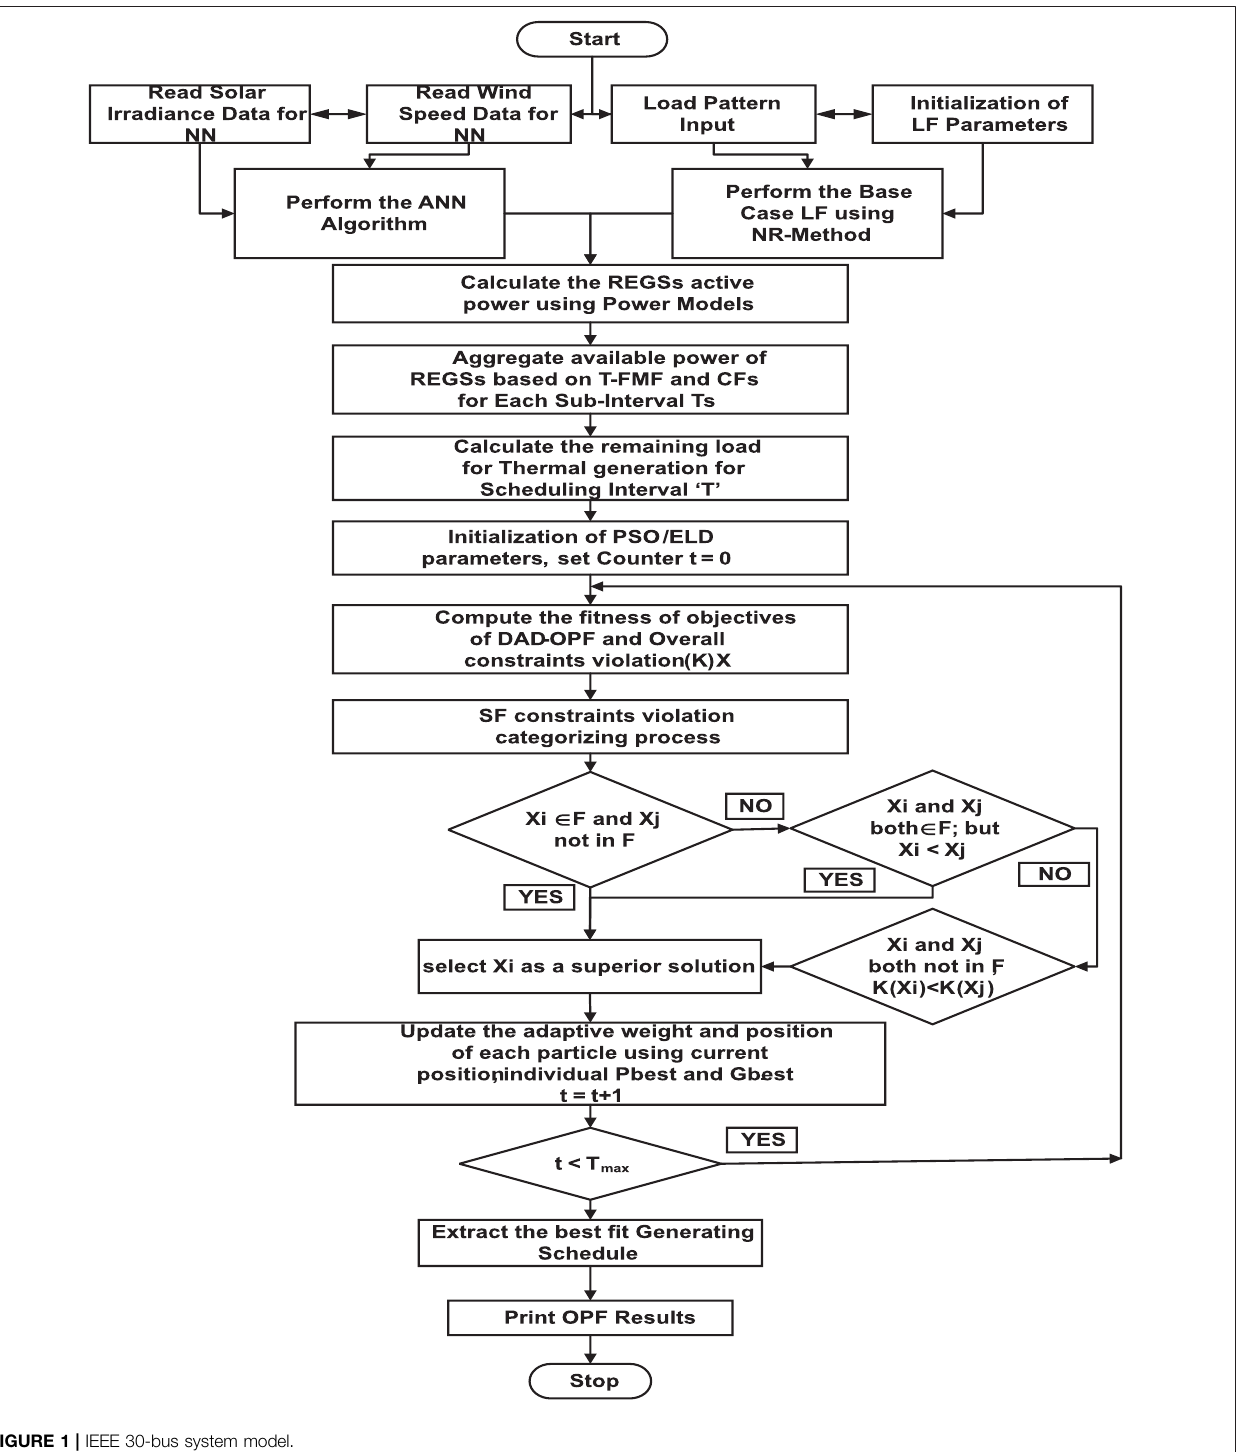
Frontiers in Energy Research |